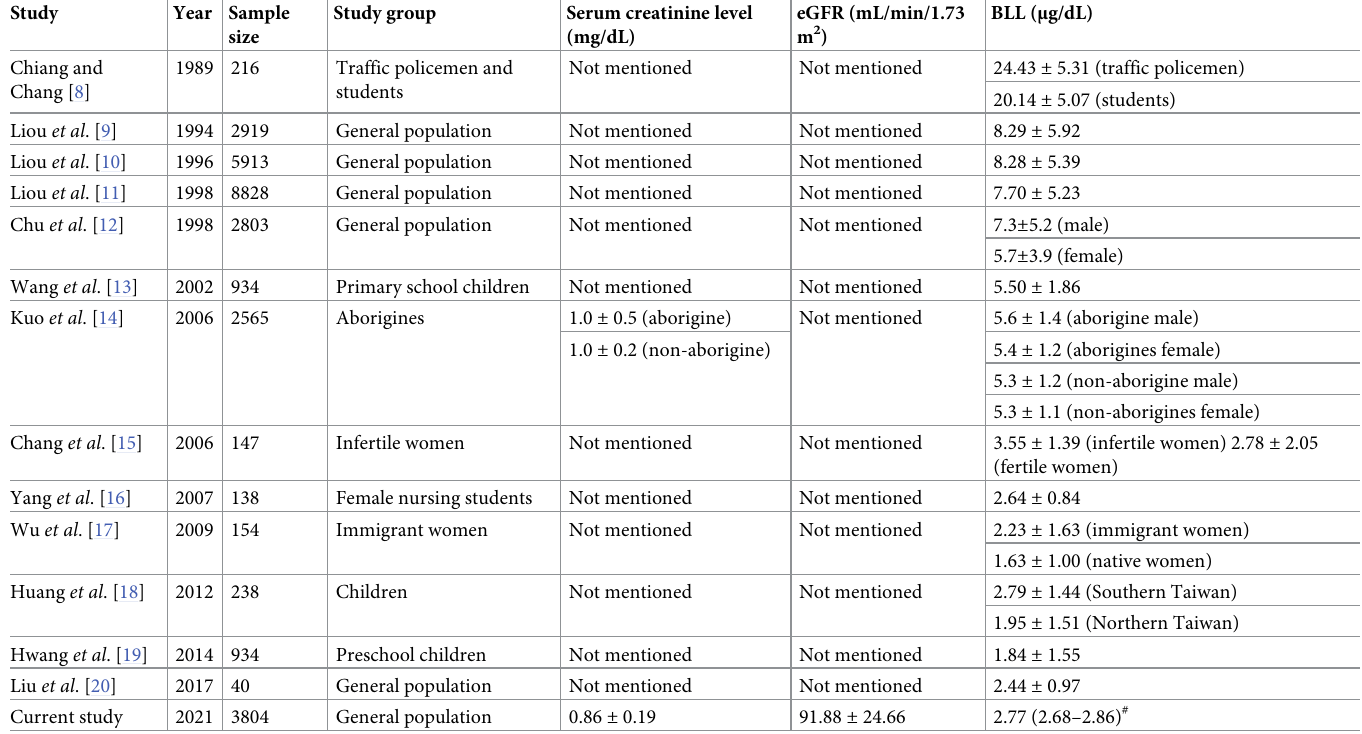
Table 3. Published blood lead prevalence studies from Taiwan.